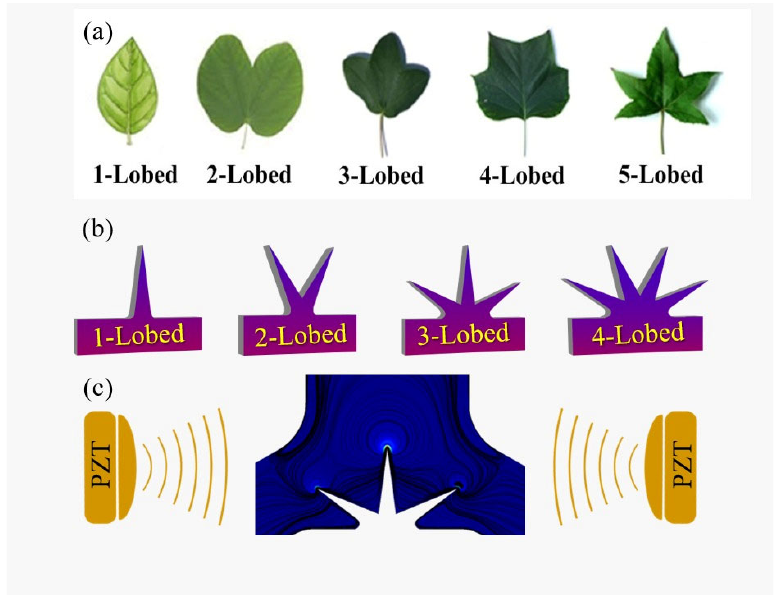
Figure 1. ( a ) The illustration of various types of multi ‐ lobed leaves structures exploited for designing the leaf ‐ shaped oscillatory sharp ‐ edges. ( b ) The schematic structure of oscillatory obstacles exploited in this study. ( c ) The illustration of piezoelectric actuators (PZT). The vibration of the piezoelectric causes the oscillatory movement of sharp ‐ edge lobes and generates multiple vortices.